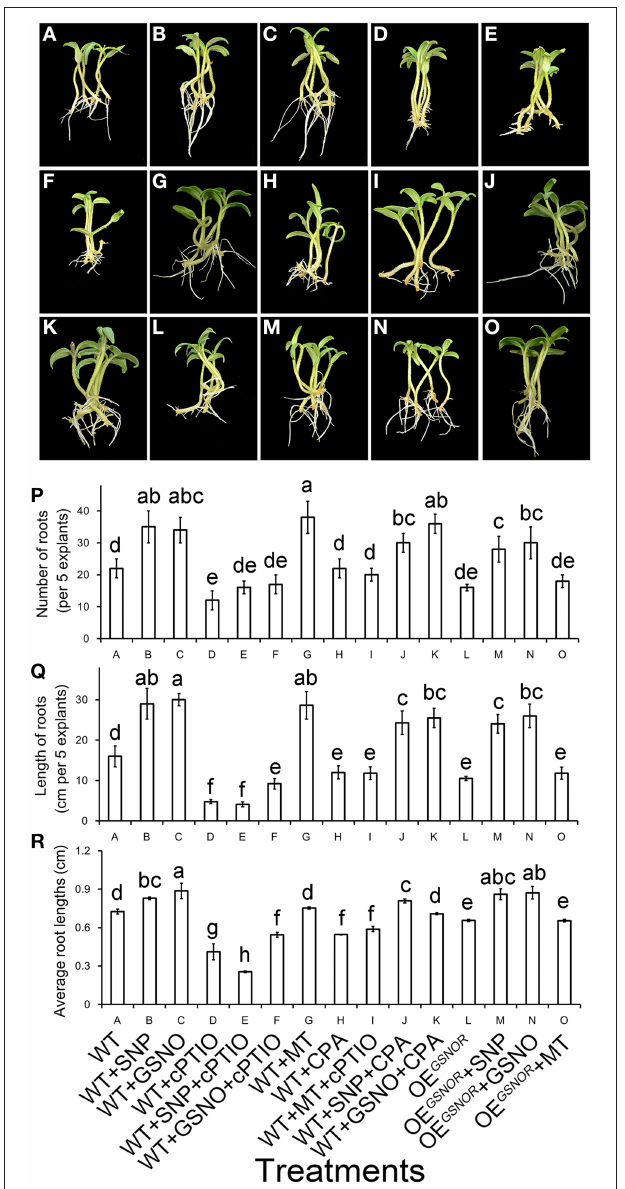
FIGURE 5 | Interactive effect of MT and NO on adventitious root formation. The primary system was removed from hypocotyls of 10-days-old germinated tomato. (A) WT; (B) WT + SNP; (C) WT + GSNO; (D) WT + cPTIO; (E) WT + SNP + cPTIO; (F) WT + GSNO + cPTIO; (G) WT + MT; (H) WT + CPA; (I) WT + MT + cPTIO; (J) WT + SNP + CPA; (K) WT + GSNO + CPA; (L) OE GSNOR ; (M) OE GSNOR + SNP; (N) OE GSNOR + GSNO; (O) OE GSNOR + MT. Photographs were taken after 5 days of treatment. (P) Root numbers in different treatments. (Q) Root lengths in different treatments. (R) Average root lengths in different treatments. These are expressed as means of five replicates ± SD, and different letters indicate significant difference ( p <